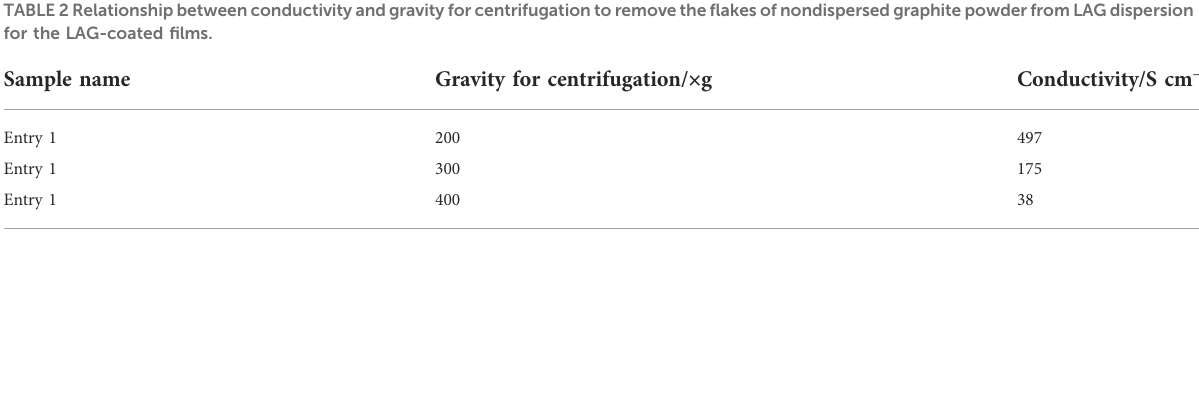
TABLE2Relationshipbetweenconductivityandgravityforcentrifugationtoremovethe fl akesofnondispersedgraphitepowderfromLAGdispersion for the LAG-coated fi